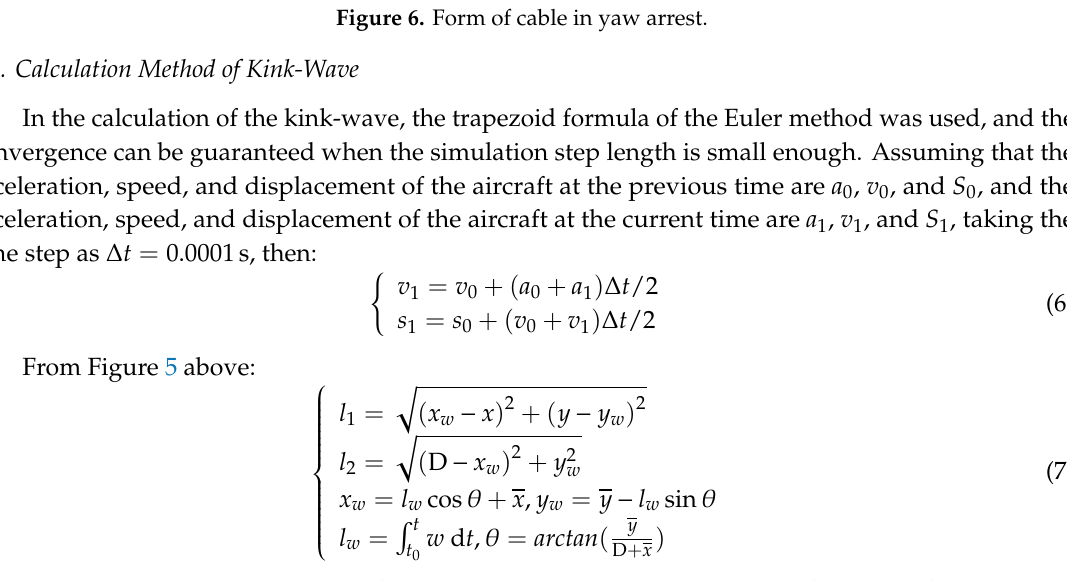
Figure 6. Form of cable in yaw arrest.